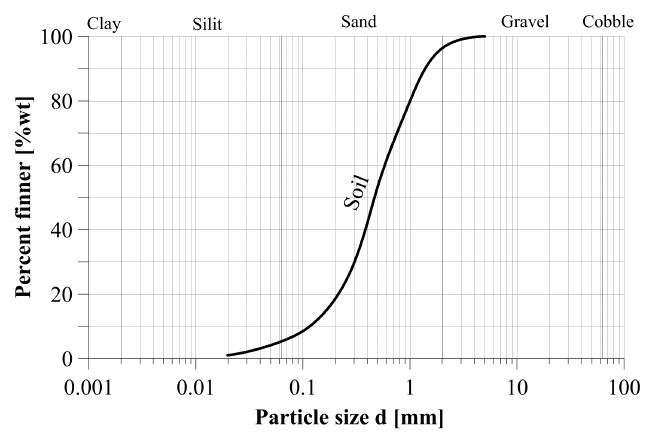
Figure 2. Grain size distribution curve of used